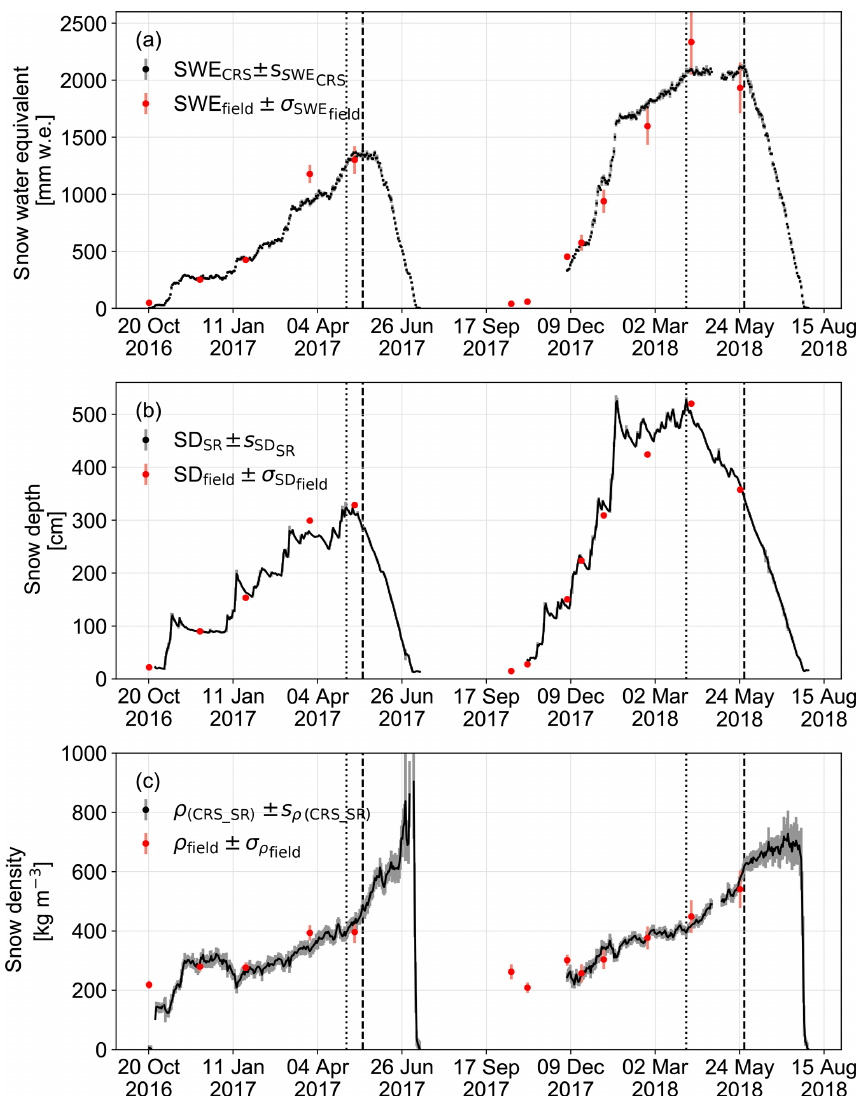
Figure 4. Continuous observations of (a) SWE, (b) SD and (c) snow density with their daily standard deviation. The red dots show the manual field measurements with their uncertainties (salmon bars). The dotted (dashed) line shows the day of the seasonal maxima in SD